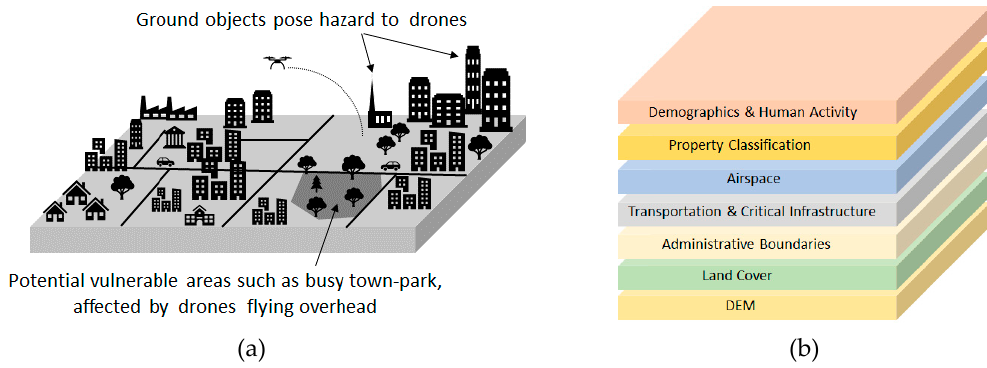
Figure 4. ( a ) Hazards and vulnerable objects; ( b ) geospatial data layers for collaborative urban airspace design.